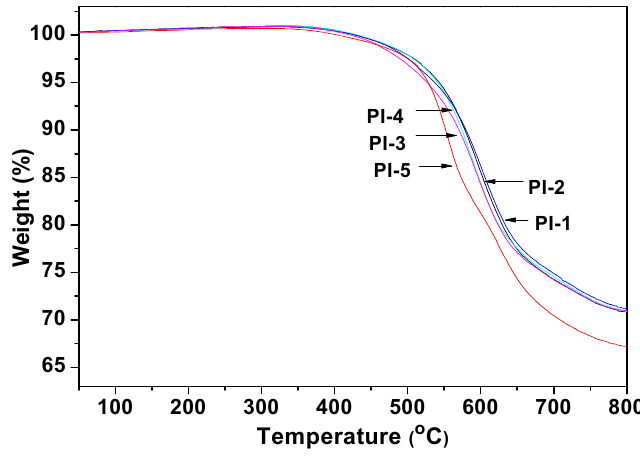
Figure 4. Thermo-Gravimetric Analysis (TGA) curves of polyimides.